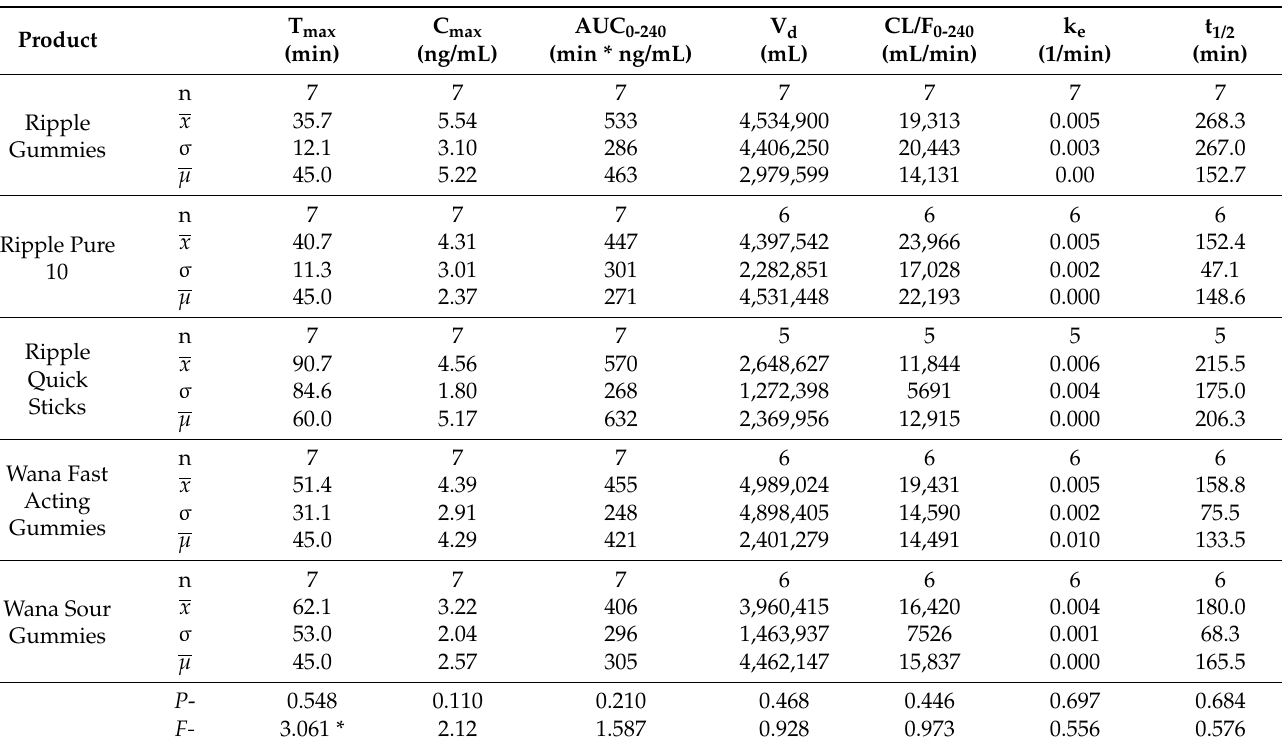
Table 3. Pharmacokinetic parameters for